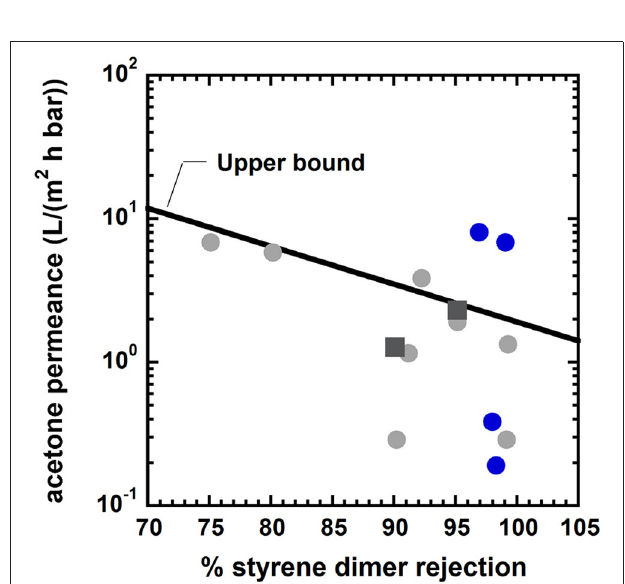
FIGURE 4 | Upper bound diagram for styrene dimers (molecular mass 236 g/mol) separation from acetone at room temperature. Solid gray circles: conventional asymmetric membranes. Solid black square: conventional composite membranes. Solid blue circles: nanoporous polyarylates synthesized by Jimenez-Salomon et al. (2016). Blue circles above the upper bound refer to polyarylates obtained using contorted, non-planar